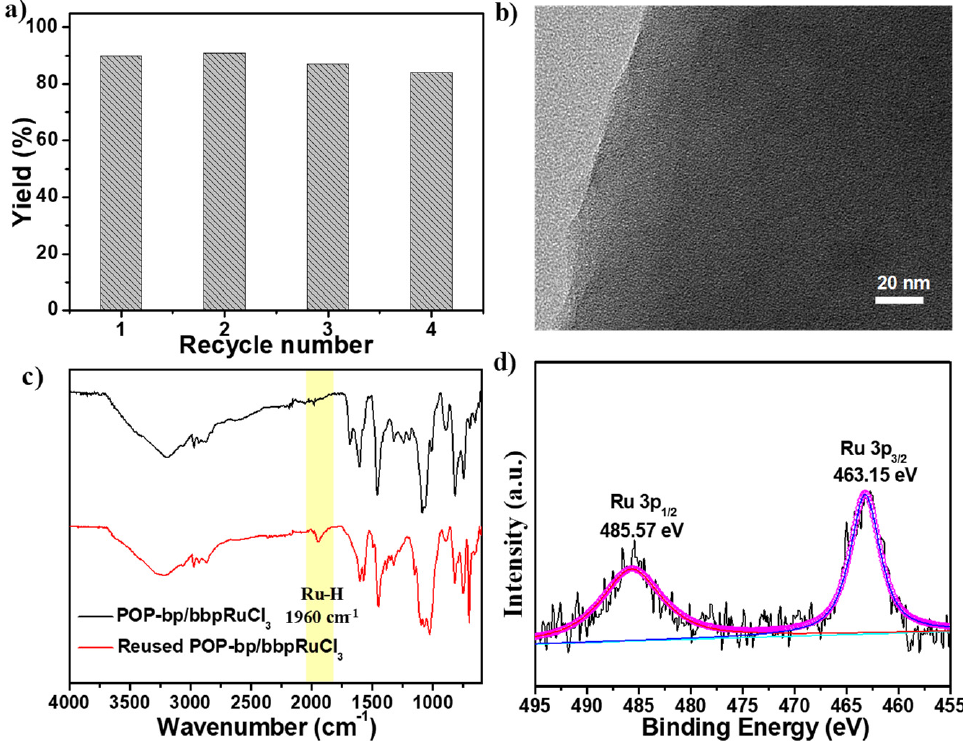
Figure 2. ( a ) Stability of the POP-bp/bbpRuCl 3 catalyst. ( b ) Transmission electron microscopy (TEM) image of the reused POP-bp/bbpRuCl 3 . ( c ) FT-IR spectra of fresh and reused POP-bp/bbpRuCl 3 . ( d ) Deconvoluted Ru 3p XPS spectrum POP-bp/bbpRuCl 3